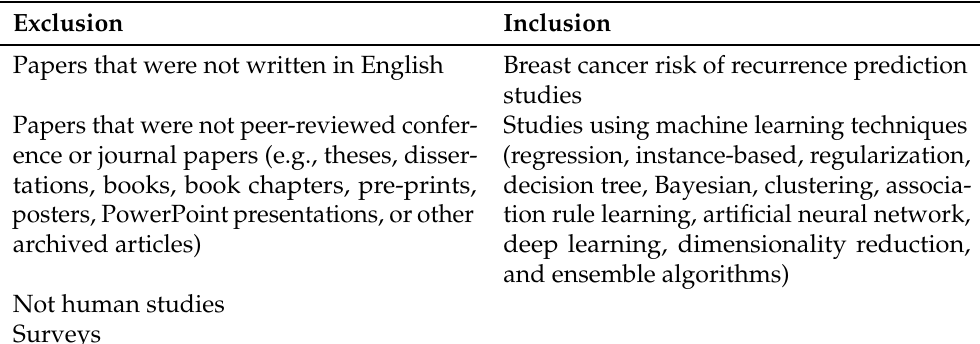
Table 1. Exclusion and inclusion criteria applied to papers based on the purpose of our systematic